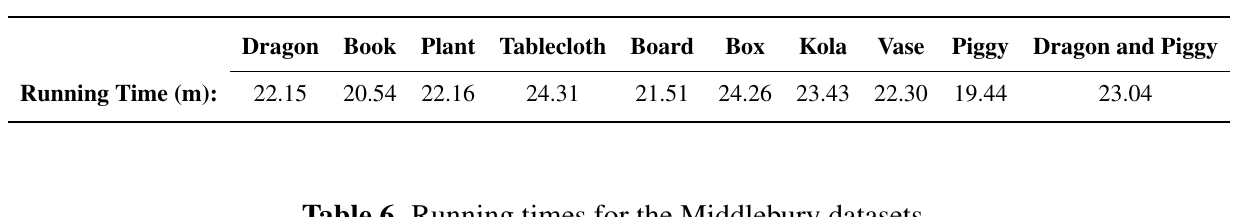
Table 6. Running times for the Middlebury